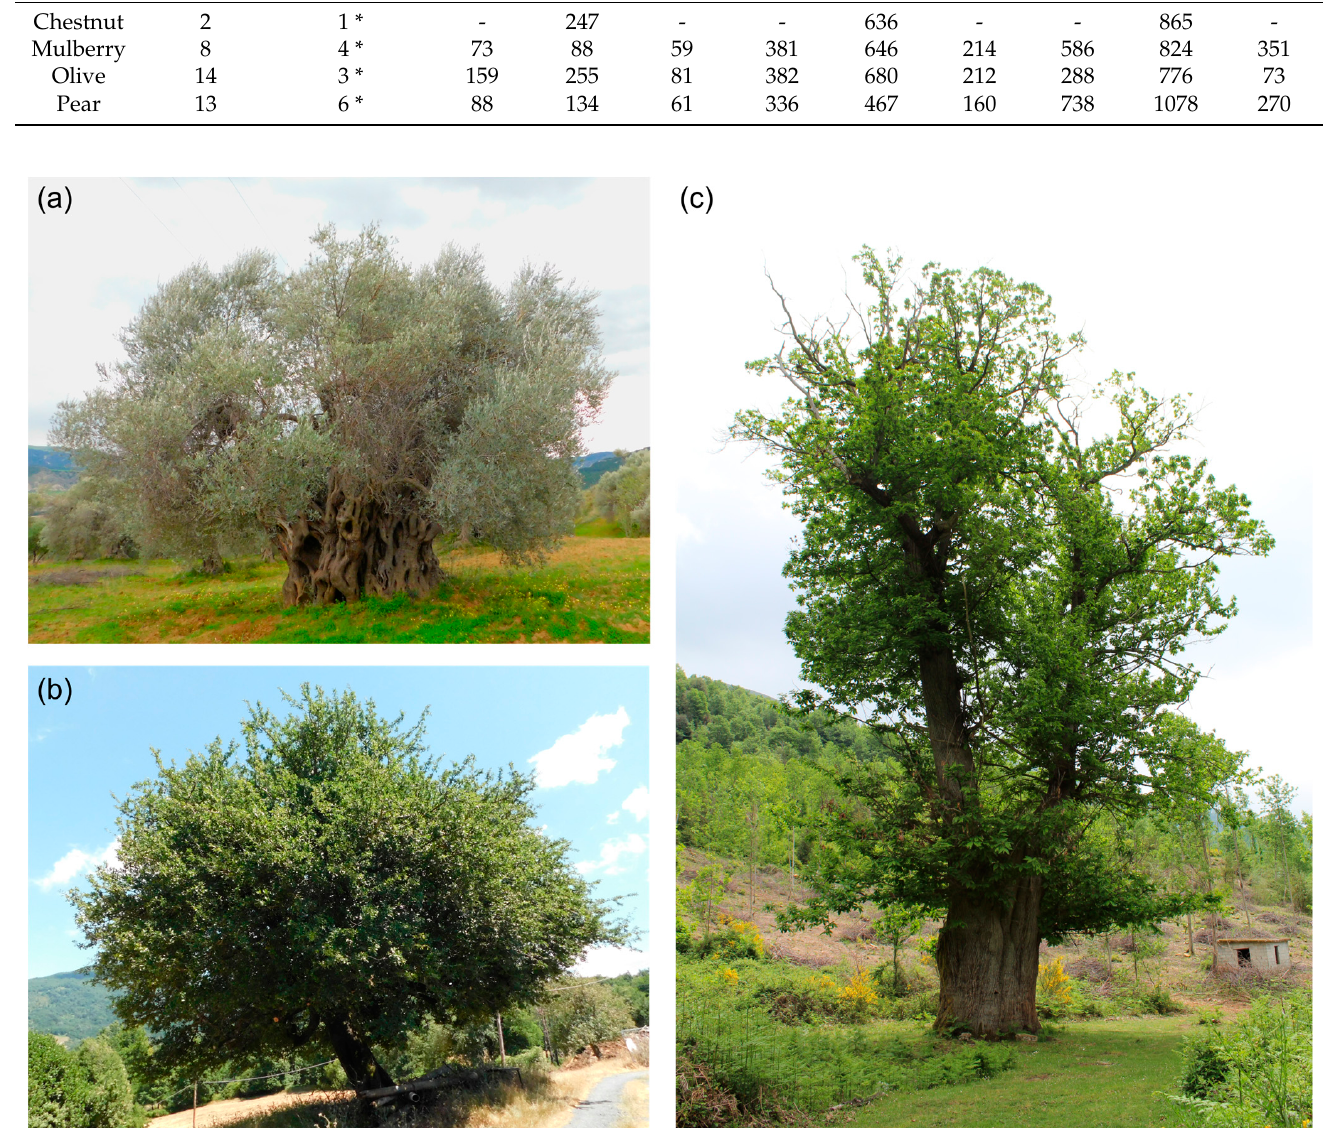
Figure 3. Very old individuals identified in this study. ( a ) The olive tree of Ferrandina: 680 ± 57 calibrated years in 2022. ( b ) The pear tree of San Severino Lucano: 467 ± 89 calibrated years in 2022. ( c ) The chestnut of Lagonegro: 636 ± 66 calibrated years in 2022. Photo credits: Domenico Cerbino. The stem pith was reached in 53 tree-ring samples, which were considered for ring